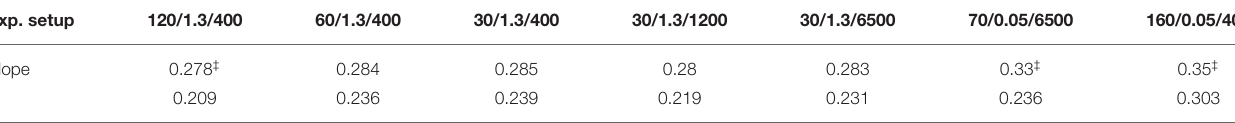
TABLE 1 | Least squares of slopes of lines shown in Figure 5D .